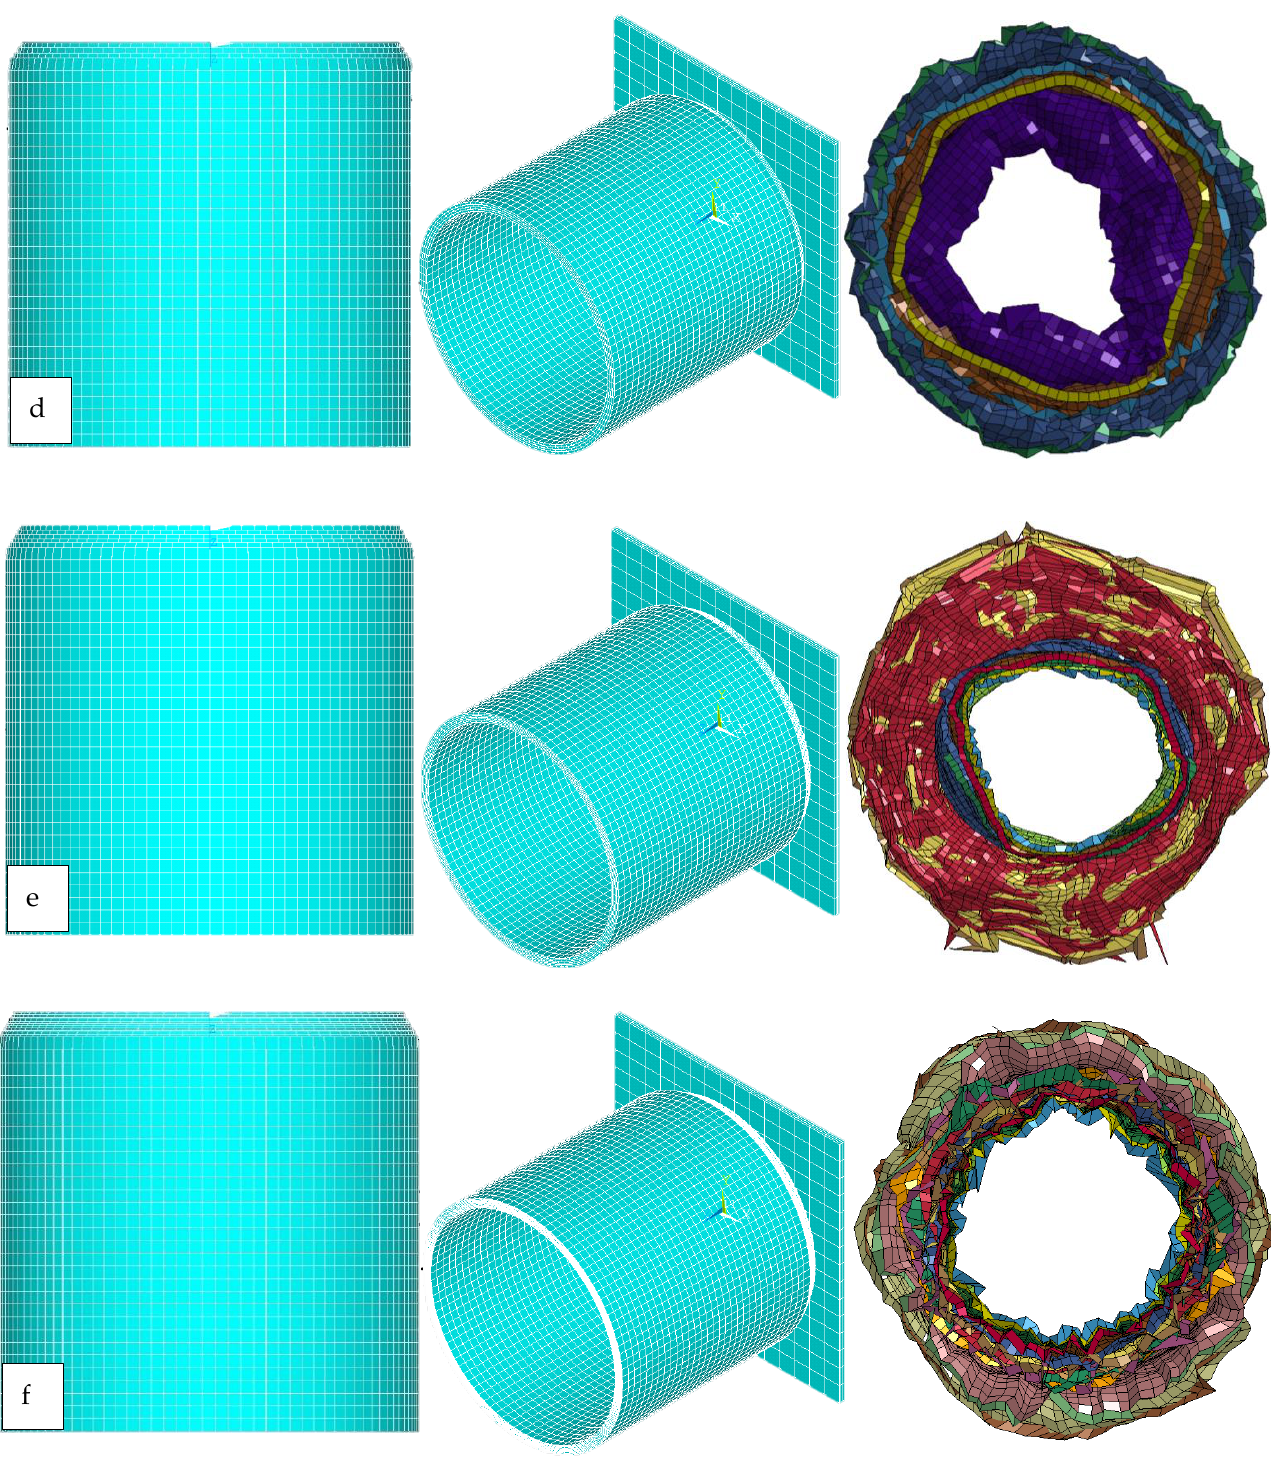
Figure 11. Number of shell configurations, ( a ) 1 shell, ( b ) 2 shells, ( c ) 3 shells, ( d ) 4 shells, ( e ) 6 shells, ( f ) 12 shells [65].